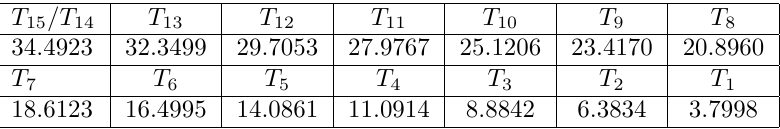
Table 1: The measured values of T n . (time unit: ns